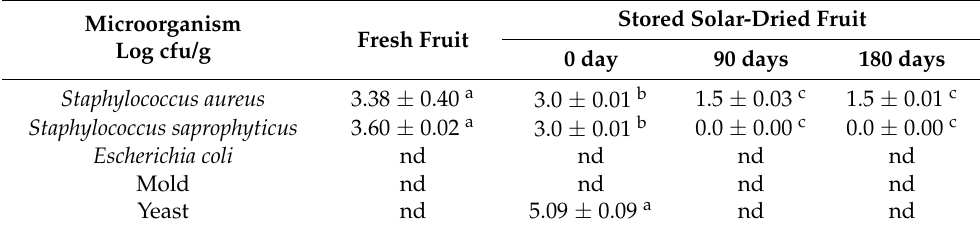
Table 2. Microbial load of fresh and solar-dried tomato slices.